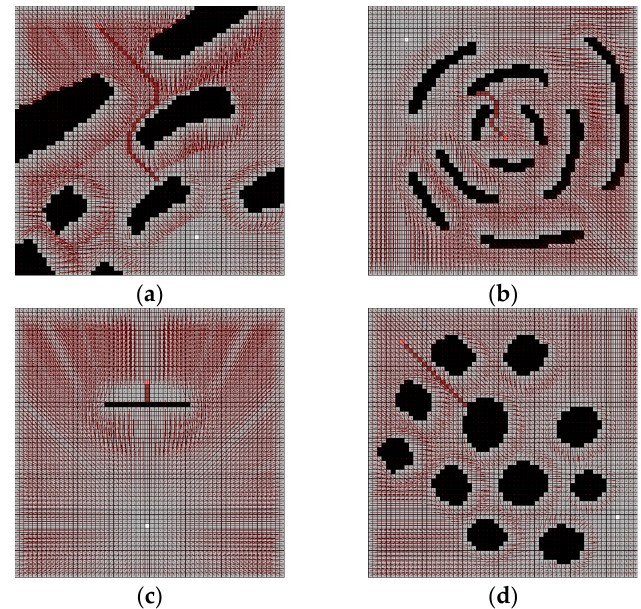
Figure 13. Several results of potential field method with the same map of water sink model in Figure 12: ( a ) test map-1 for potential field method; ( b ) test map-2 for potential field method; ( c ) test map-3 for potential field method; ( d ) test map-4 for potential field method.